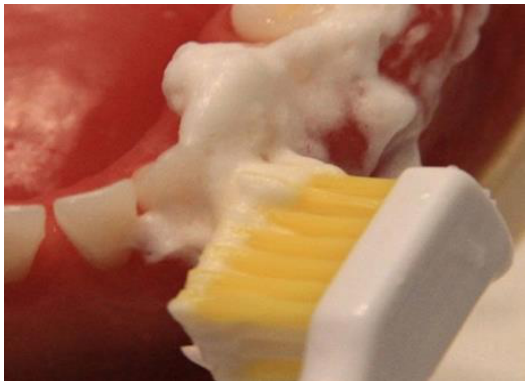
Figure 5. Sonic toothbrush in action.